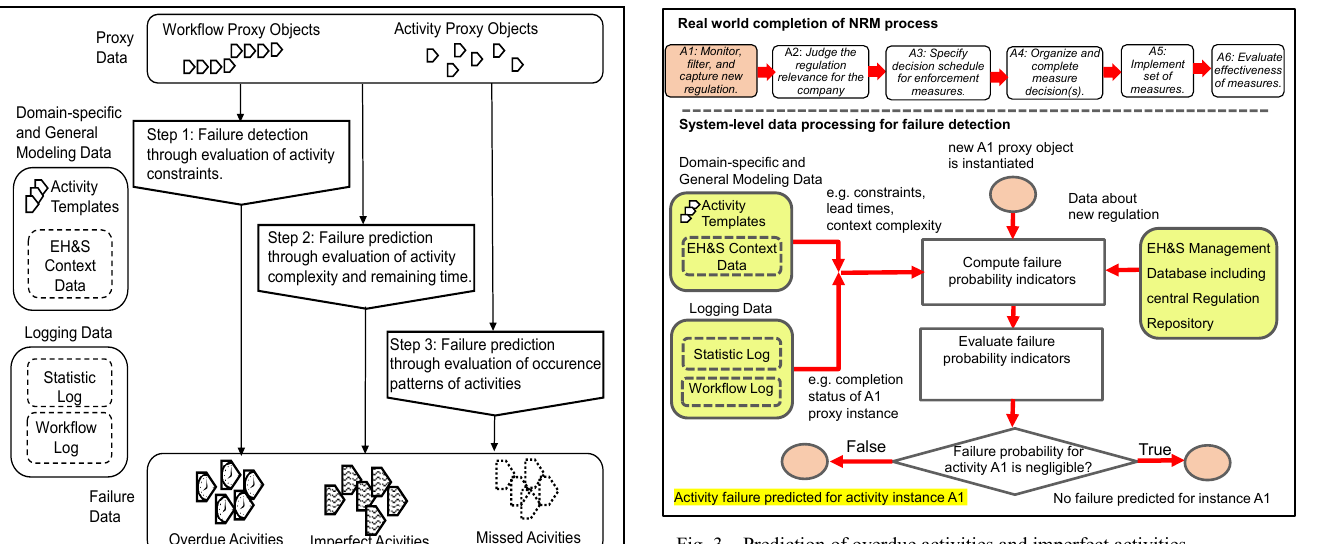
Fig. 3. Prediction of overdue activities and imperfect